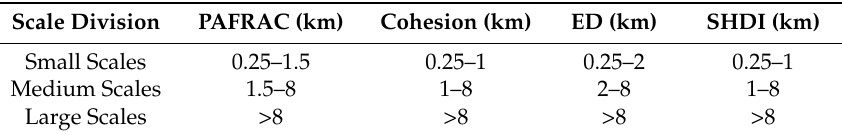
Table 3. The main scale intervals of selected landscape metrics in profile